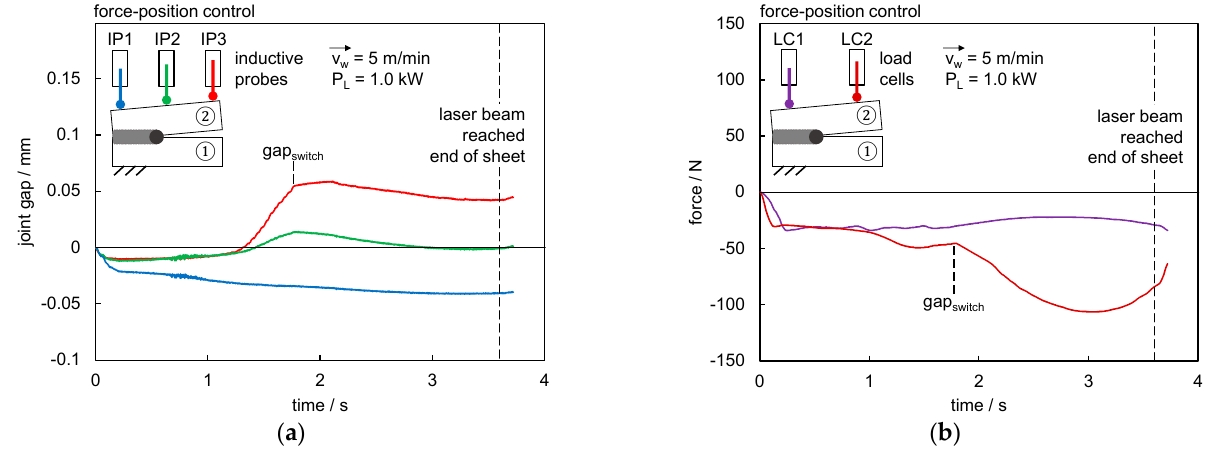
Figure 17. Closed-loop force-position control (v w = 5 m/min, P L = 1.0 kW): ( a ) gap measurement via inductive probes; and ( b ) force measurement via load